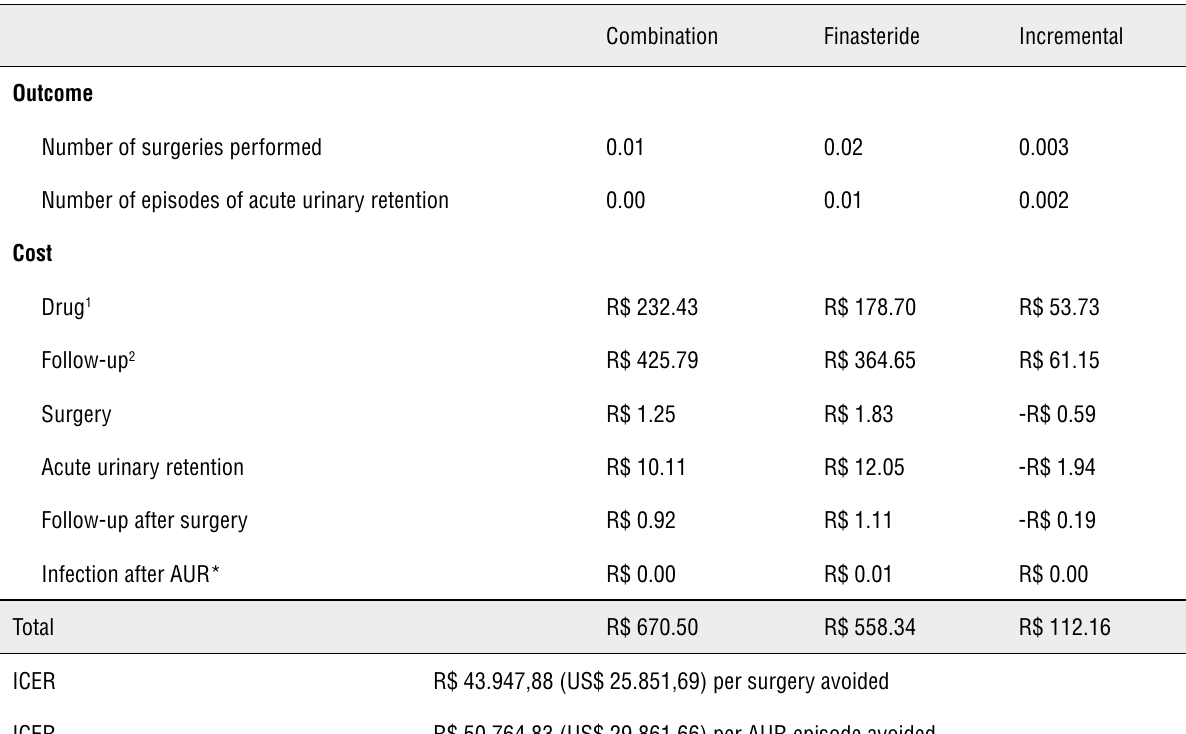
Table 3 - Efficacy and incremental costs with the combination of doxazosine + finasteride and monotherapy with finasteride in a 4 year period (per